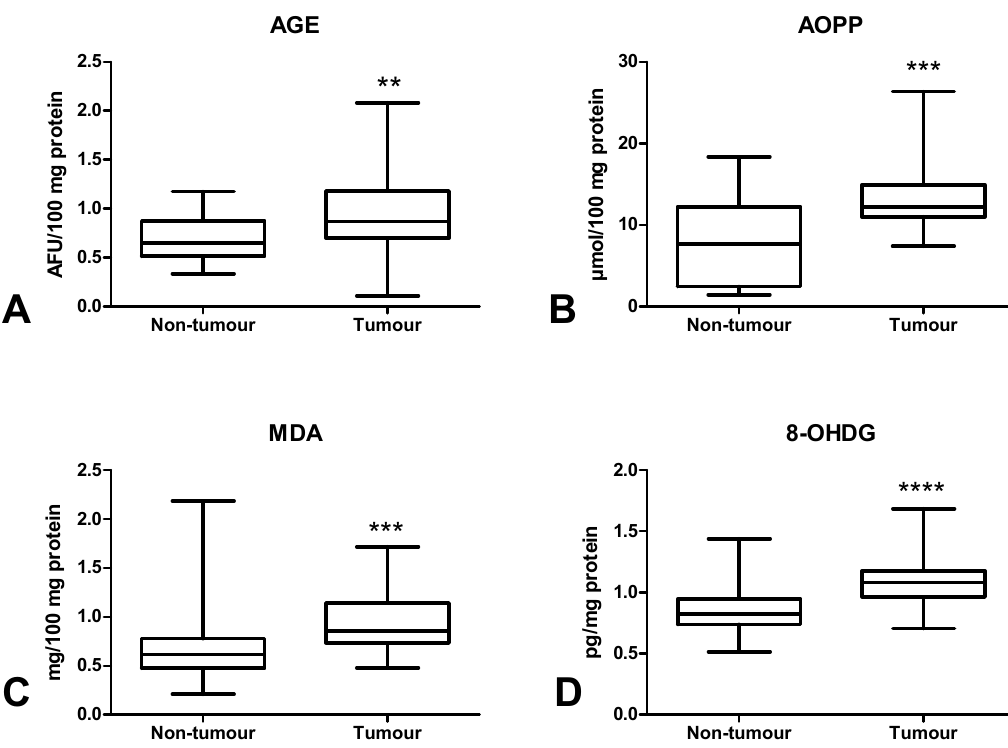
Figure 8. Comparison of AGE ( A ), AOPP ( B ), MDA ( C ) and 8-OHdG ( D ) concentration between colorectal cancer tissue ( n = 29) and normal mucosa ( n = 29). The data are presented as median (minimum–maximum). Abbreviations: AGE—advanced glycation end products, AOPP—advanced oxidation protein products, MDA—malondialdehyde, 8-OHdG—8-hydroxydeoxyguanosine. ** p < 0.01, *** p < 0.001, **** p < 0.0001.